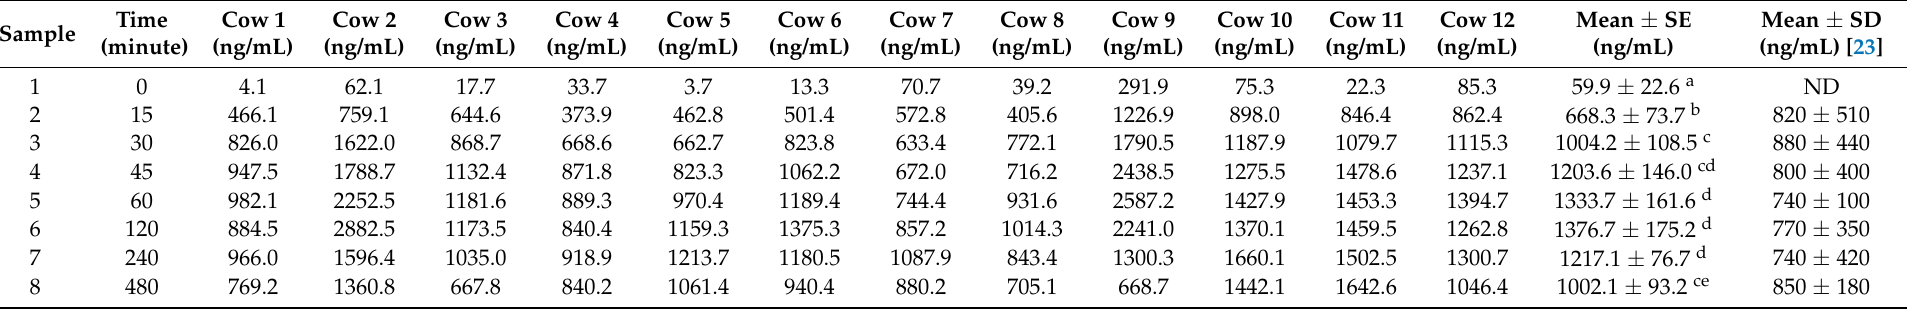
a–e values bearing different letters indicate a statistical difference ( p < 0.05). ND: Not detectable within the limits of the assay. SE: Standard Error, SD: Standard